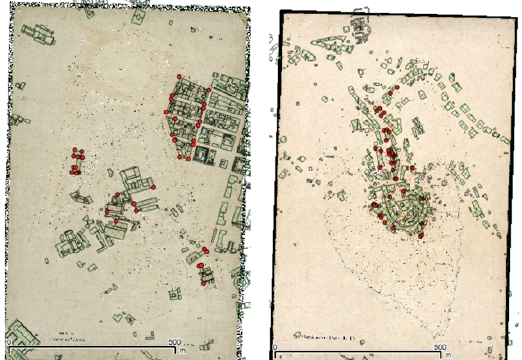
Figure 4. Point distribution: Piazza del Colosseo (left) and Castelnuovo di Porto (right)